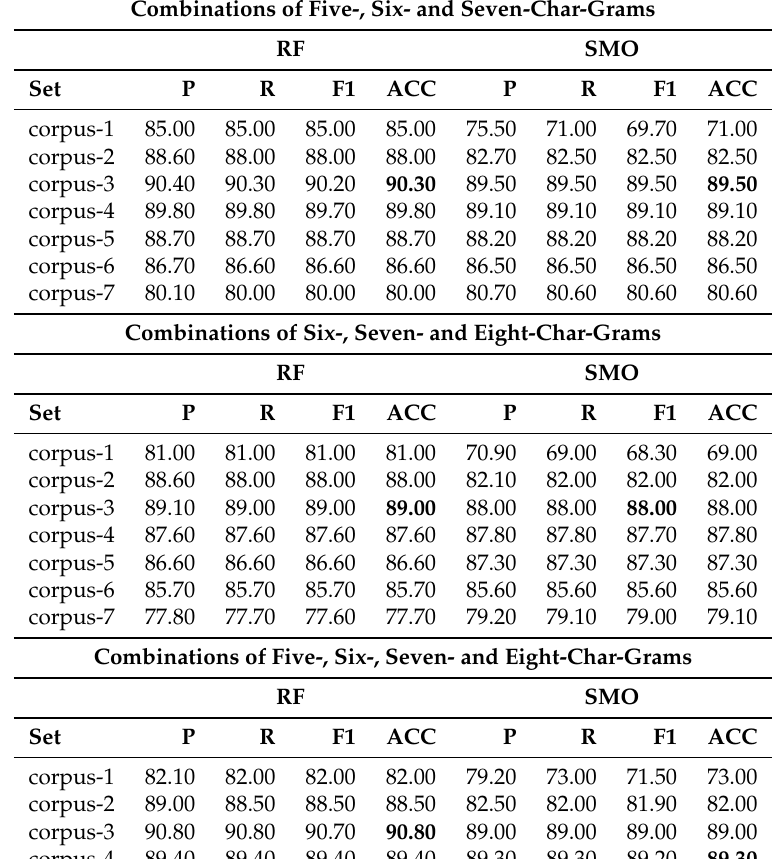
Table 7. Results using triplets of fixed-length character for the char-gram model and by mixing all the fixed length character